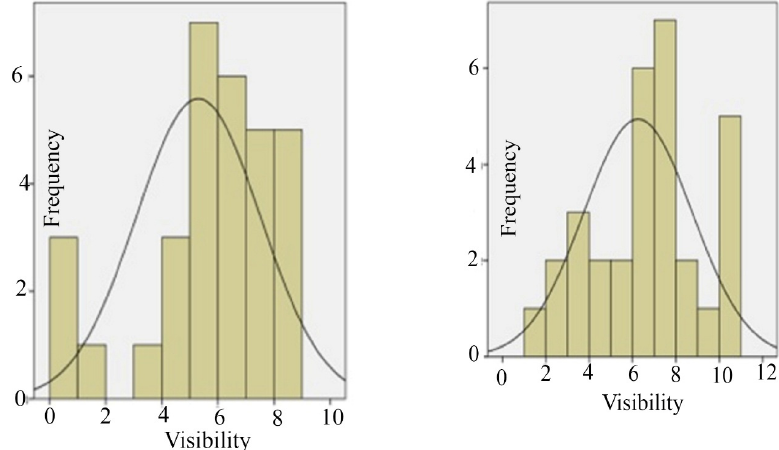
Figure 10. Temperature frequency in August 2008 ( Left ) and 2009 ( Right ).